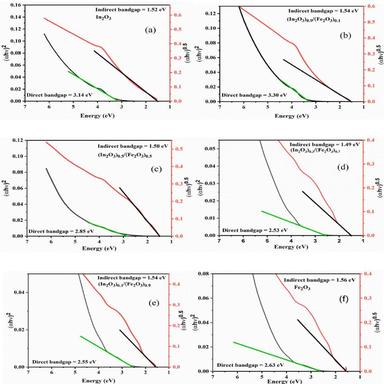
Tauc plot for all synthesized In2O3/Fe2O3 nanocomposite samples.